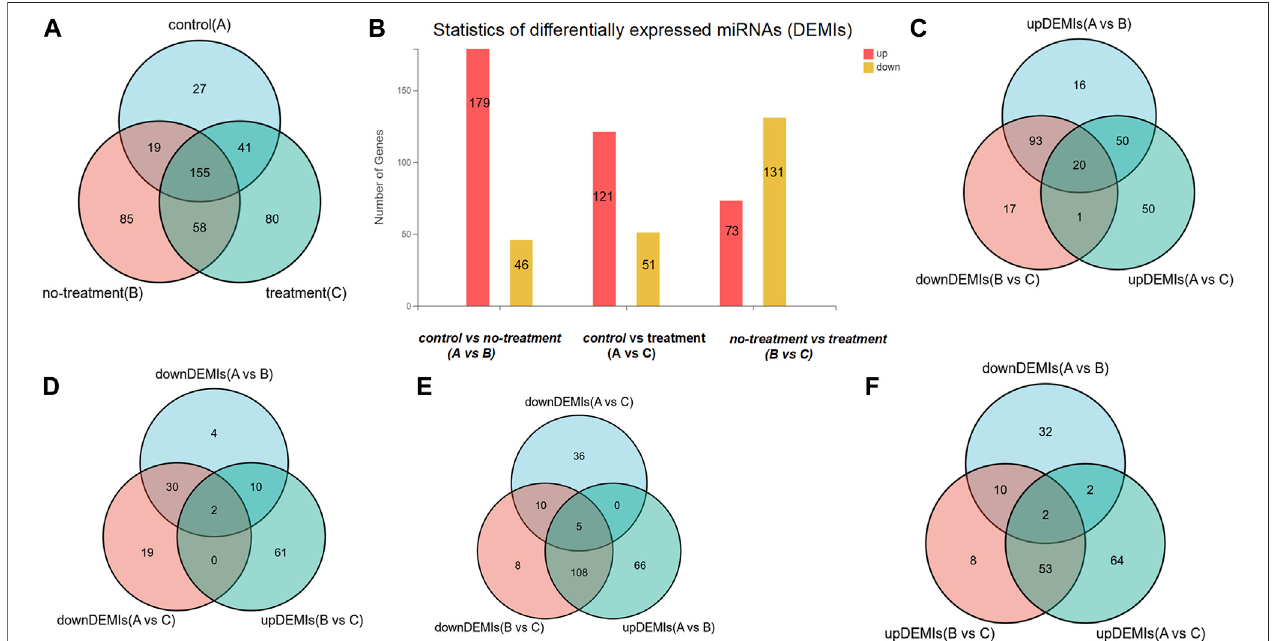
FIGURE 1 | The distribution of differentially expressed miRNAs (DEMIs). (A) Venn diagram shows there are respectively 242, 317, and 334 DEMIs in control, treatment,andno-treatment groups. (B) BargraphrevealsthestatisticofDEMIs,respectively179up-DEMIsand46down-DEMIs,121up-DEMIsand51down-DEMIs, and73up-DEMIsand131down-DEMIsinthecomparisongroupofcontrolvs.no-treatment,controlvs.treatment,andno-treatmentvs.treatment,whichwasencoded asAvs.B, Avs. C,and Bvs.C. (C) Venndiagramscreenedout20miRNAs commonly existed inthecomparison group ofup-DEMIs(A vs.B),up-DEMIs(A vs.C), and down-DEMIs (B vs. C). (D) Venndiagram showstwo miRNAs thatcommonly existed in thecomparison group ofdown-DEMIs(Avs. B), down-DEMIs (A vs. C), and up-DEMIs (B vs. C). (E) Venn diagram shows fi ve miRNAs that commonly existed in the comparison group of up-DEMIs (A vs. B), down-DEMIs (A vs. C), and down- DEMIs (B vs. C). (F) Venn diagram shows two miRNAs that commonly existed in the comparison group of down-DEMIs (A vs. B), up-DEMIs (A vs. C), and up-DEMIs (B vs.